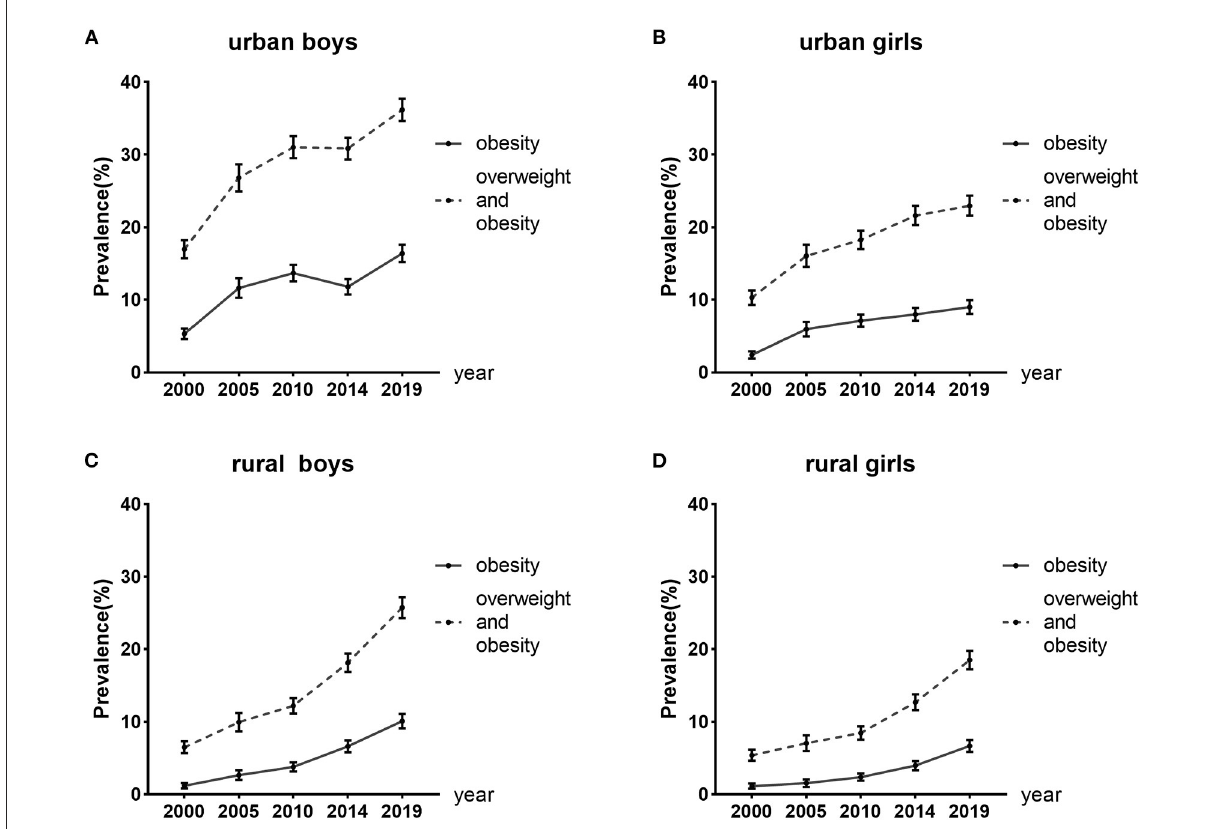
FIGURE2 Trends in overweight and obesity prevalence from 2000 to 2019 in different location and sex. Error bars represent 95% confidence